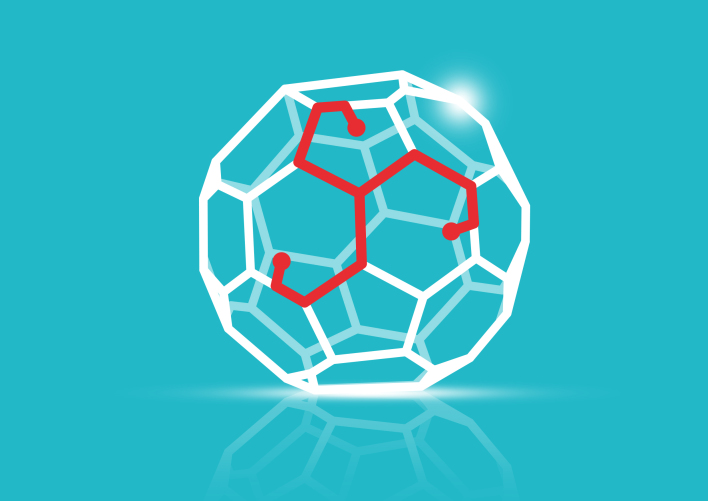
Congenital inability to feel pain is rare, but the identification of causative genes is translating into the development of novel analgesics. Nahorski et al. describe insensitivity to pain caused by mutations affecting the second clathrin heavy chain (CHC22), and reveal a role for CHC22 in pain and touch development.